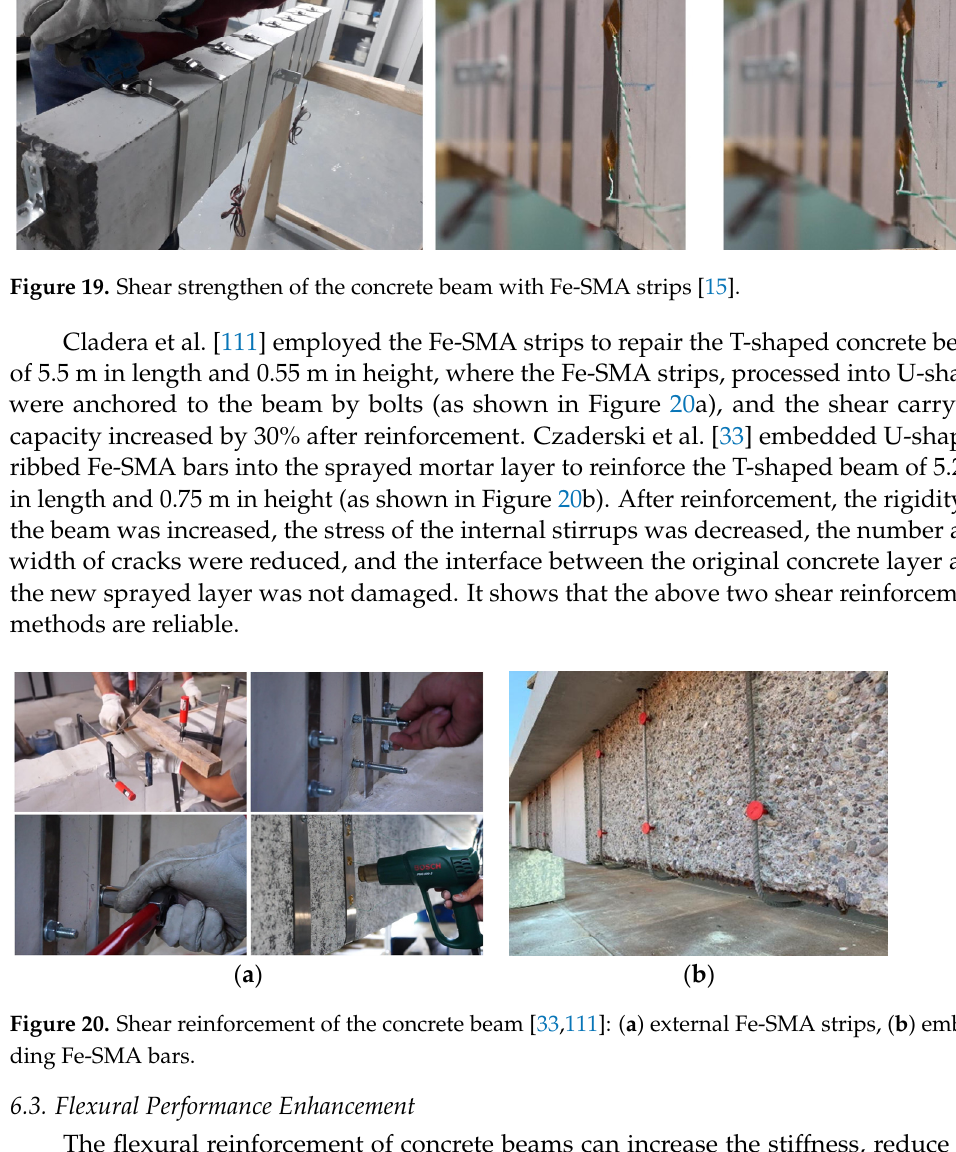
( b ) Figure 18. Internal installation modes: ( a ) NSM technology, ( b ) embedding Fe-SMA bars/strips. 6.2. Shear Performance Enhancement Shear cracks often occur in concrete beams under load. Reinforcements shall be used to delay the occurrence of cracks, to reduce the crack width in the normal use stage, and to avoid the shear damage of concrete beams due to insufficient bearing capacity. Soroushian et al. [46] initially employed Fe-SMA rods to externally reinforce the shear cracks of a bridge in Michigan, USA. The Fe-SMA rods were anchored to the con- crete beam through a bolted connection device. The average crack width was reduced from 0.55 mm to 0.32 mm after reinforcement (reduced by about 40%), effectively improv- ing the shear bearing capacity. However, due to the need to move and expand the anchor holes, the target prestress (176 MPa) of the Fe-SMA rods was not reached, and the final prestress was 120 MPa after activating Fe-SMA.